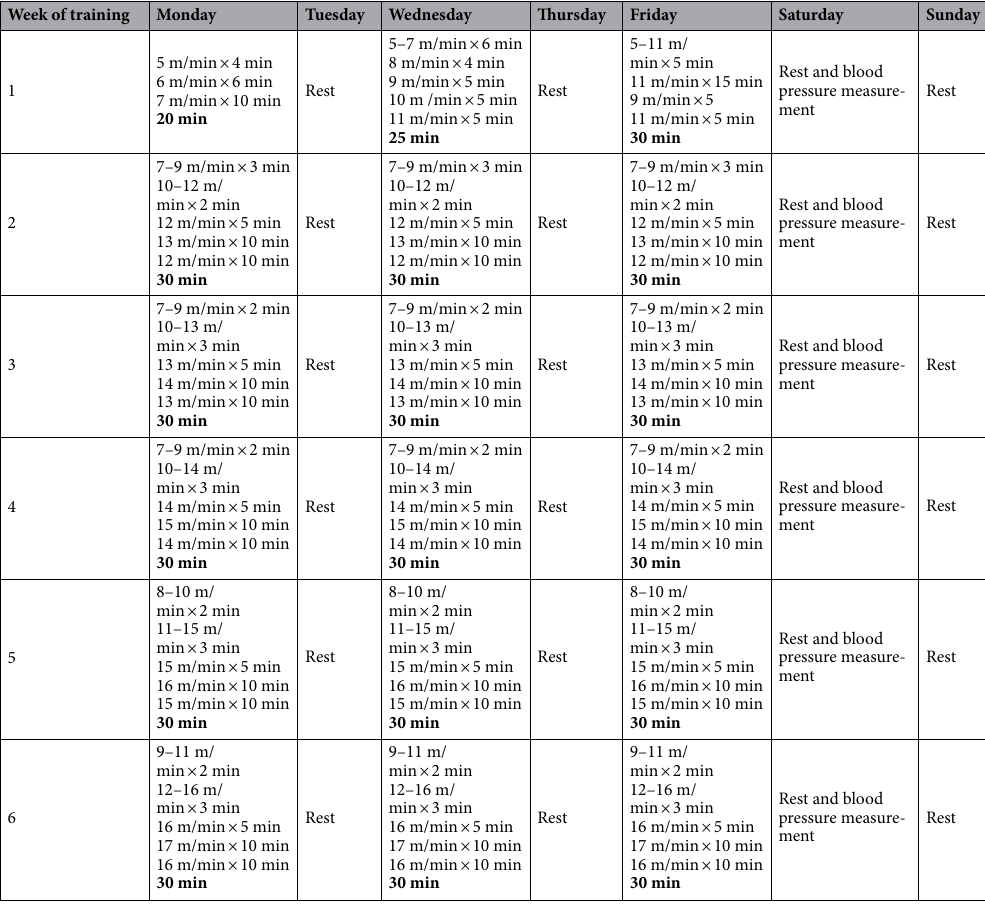
Table 2. Training session planning. Significant values are in